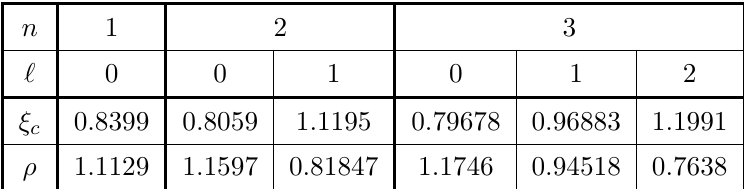
Table 4 . The (cid:12)t parameters (cid:24) c and (cid:26) , in the (cid:12)tting formula (cid:13) n‘ ( (cid:24) ) ’ (1 =n )(1 (cid:0) n 2 (cid:24) c =(cid:24) ) (cid:26) , for the energy eigenvalues E n‘ = (cid:0) (cid:13) 2 ( (cid:24) ) (cid:2) (cid:20) 2 = (2 (cid:22) ). In the Coulomb limit, lim (cid:24) !1 (cid:13) n‘ ( (cid:24) ) = 1 =n . n‘